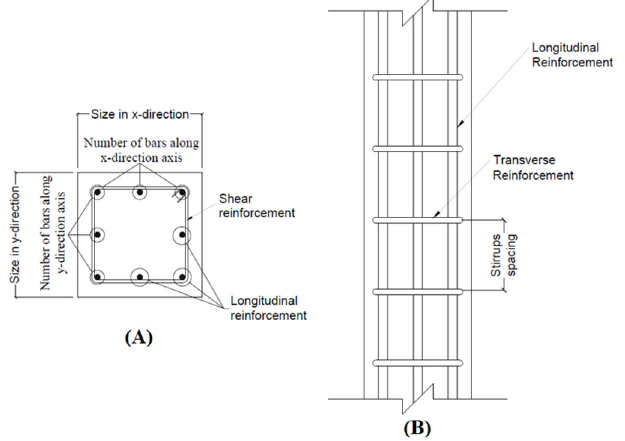
Figure 6. Columns controlling design variables (V 11 , V 12 , and V 13 ): ( A ) Columns section view; ( B ) Columns elevation view.